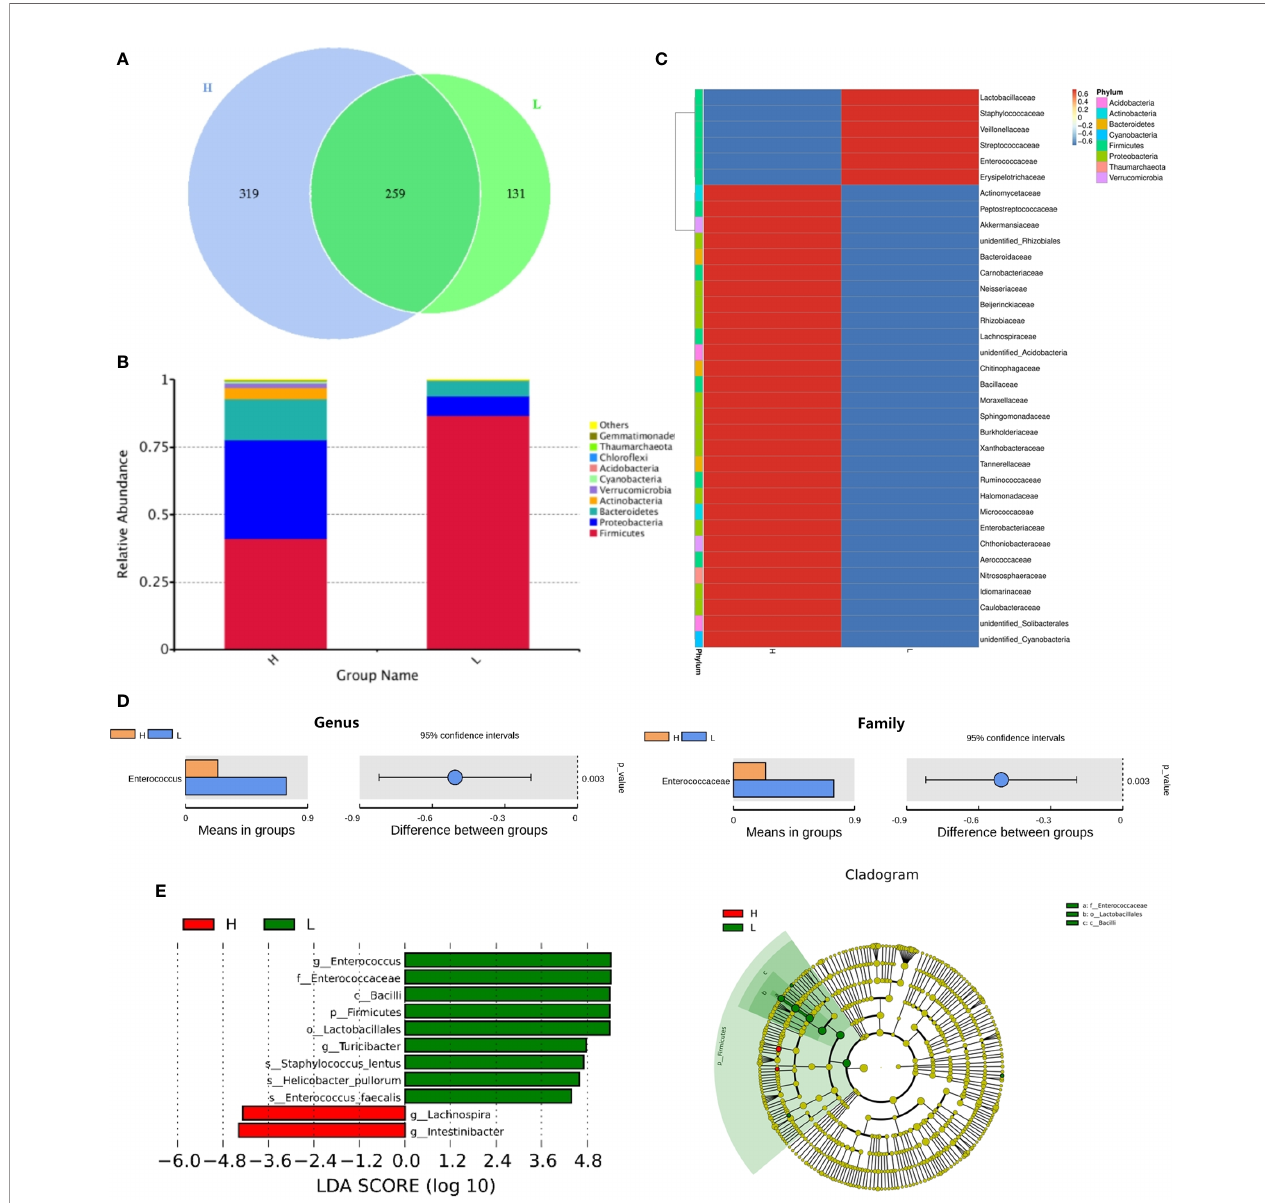
FIGURE 2 | The comparison of the intestinal fl ora abundance of recipients on posttransplant 14 days between high number of mucosa-associated invariant T (MAIT) cells (>5.3 × 10 6 /kg, H group, n = 12) and low number of MAIT cells (<5.3 × 10 6 /kg, L group, n = 10) in infused grafts. (A) Venn diagram, each circle represents a group, the number in the overlapped part of the circle and circle represent the number of operational taxonomic units (OTUs) shared between the two groups, and the number without overlap represents the unique OTUs of the group. (B) The column chart of relative abundance of species at phylum level. The abscissa is the group name. The ordinate (Relative Abundance) represents the relative abundance. Others represents the sum of the relative abundances of all the phyla except these 10 phyla in the fi gure. (C) Cluster heat map of species abundance at the genus level. According to the species annotation and abundance information of all samples at the genus level, select the top 35 abundant genera. (D) T-test species difference analysis diagram at the genus and family levels between H and L groups. (E) Latent Dirichlet Allocation (LDA) score distribution histogram and cladogram. The LDA score distribution histogram shows the Biomarker species with statistical differences between the groups whose LDA Score is greater than the set value (the default setting is 4). The length of the histogram represents the impact of different species (that is, LDA Score). In the cladogram, the circles radiating from the inside to the outside represent the taxonomic level from the phylum to the genus (or